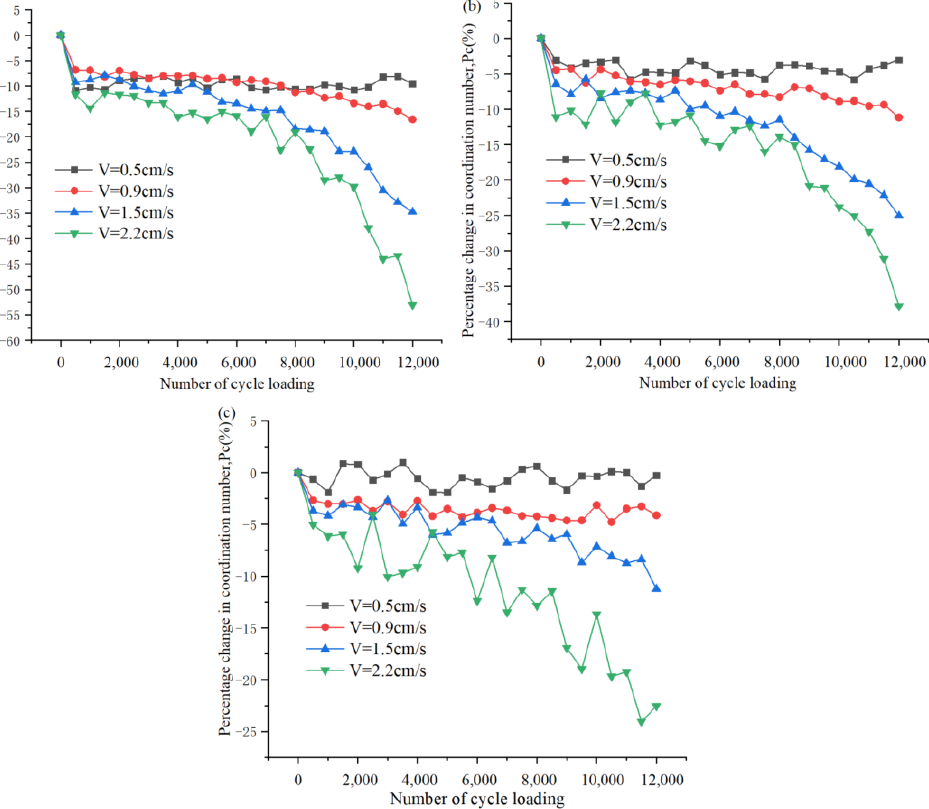
Figure 5. Change of coordination number characterizing the softening process of the slip zone soil: ( a ) 50 kPa; ( b ) 100 kPa; ( c ) 200